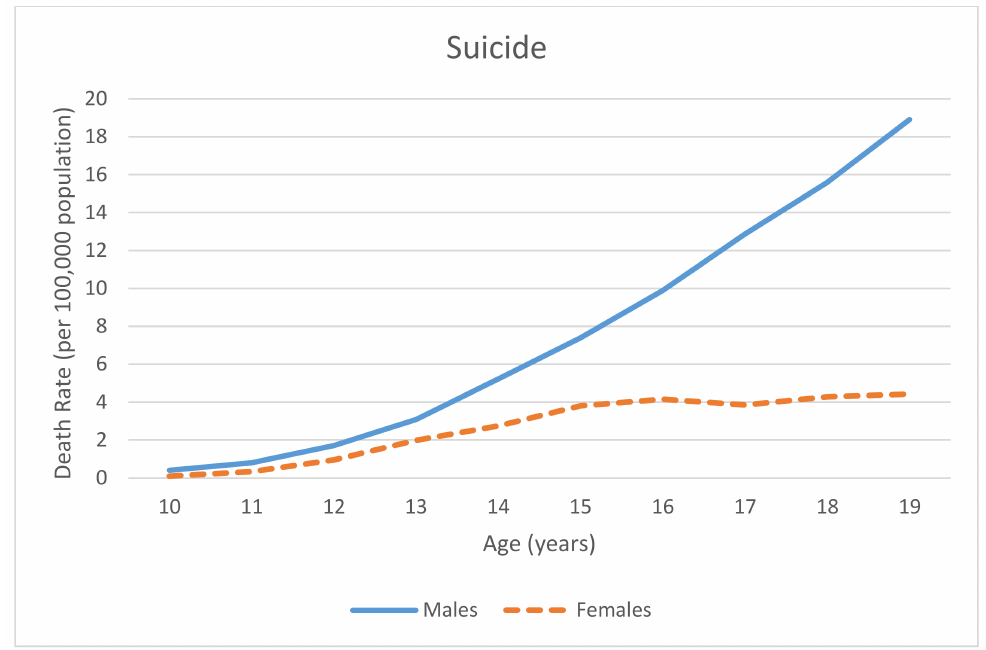
Figure 5. Injury and violence related death rates (per 100,000 population) among youth (ages 0–19 years) by intent, mechanism, and age group, National Vital Statistics System, United States, 2011–2015. Note: The scales for the vertical axes are different for each intent and